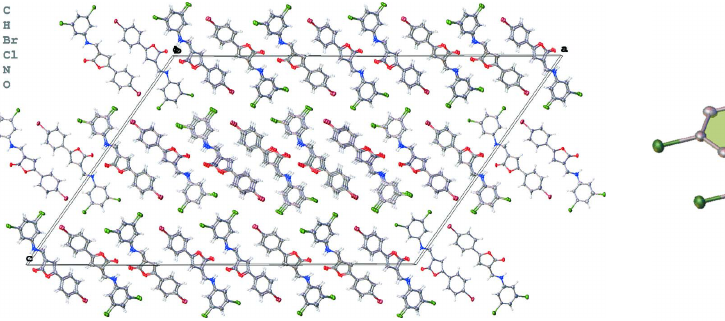
Figure 3 (cid:2) – (cid:2) stacking interactions between the dichloro (green) and bromo (brown) substituted aromatic rings of the title compound.